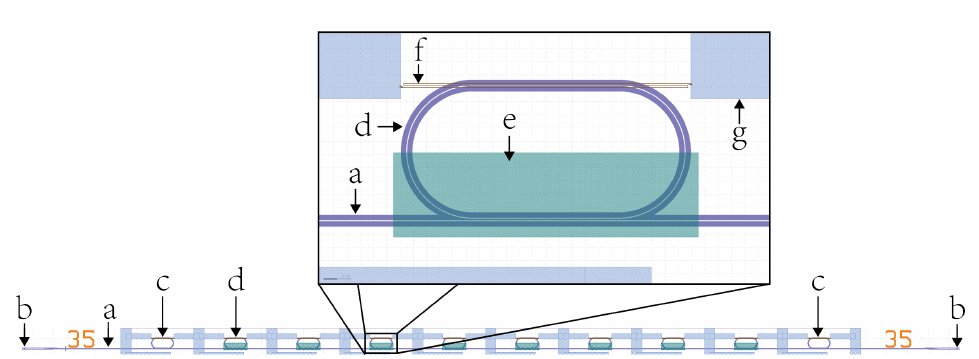
Figure 3. Chip design of the waveguides used in the experimental part of this work. The optical waveguides (trenches (a) shown in purple) start and end in grating couplers (b). Of the 10 racetrack ring resonators ((c) and (d), also in purple) coupled to the waveguide, eight have opened areas ((e), green) to allow for the sample interaction. The first and last ring resonators (c) are used for reference measurements. Electrical contacts ((g), blue) connect to heating wires ((f), brown) used for modulating individual ring